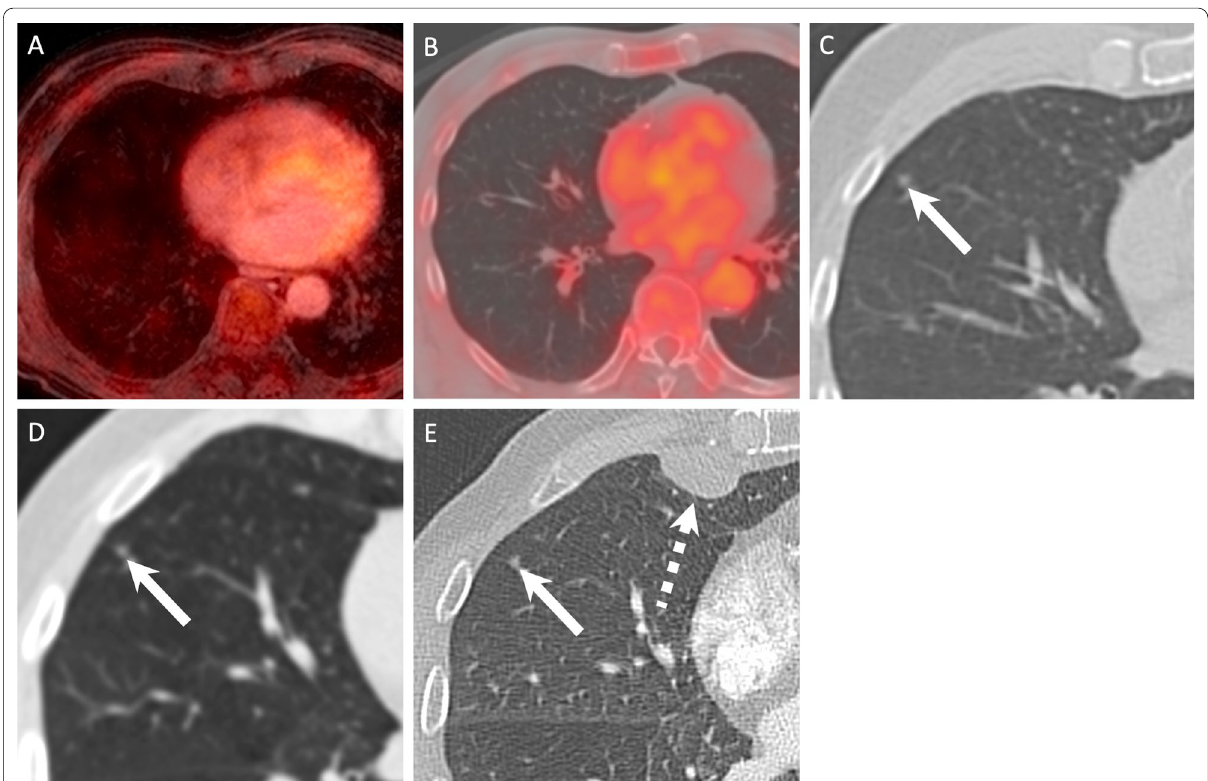
Fig. 5 False-negative PET/MRI ( A ) and PET/CT ( B ) in an 89-year-old male with primary SCC of the oral cavity. Both PET/MRI and PET/CT were rated as negative for distant metastases or second primary cancers (diagnostic score 1). PET/MRI image ( A ) shows no lesion. PET/CT ( B ) and detail of the = corresponding CT component of the PET/CT ( C ) show a non-[ 18 F]FDG-avid 5 mm solid lung nodule (arrow in C ), which was considered as benign according to diagnostic criteria (no [ 18 F]FDG uptake and < 8 mm in size). The lesion was rated with a score of 1 on PET/MRI and PET/CT. Follow-up CT obtained two months later ( D ) showed no change in size and shape of the 5 mm nodule (arrow). CT obtained 7 months later ( E ) revealed no change in the 5 mm nodule (arrow), however, a pleural metastasis (dashed arrow) that was confirmed histologically. As the pleural metastasis occurred within the 2-year follow-up, both PET/CT and PET/MRI were considered as false